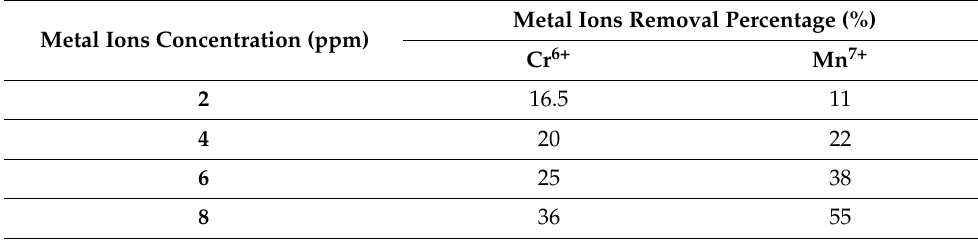
Table 4. Removal percentage of dichromate (Cr 6+ ) and/or permanganate (Mn 7+ ) ions from contami- nated wastewater under batch